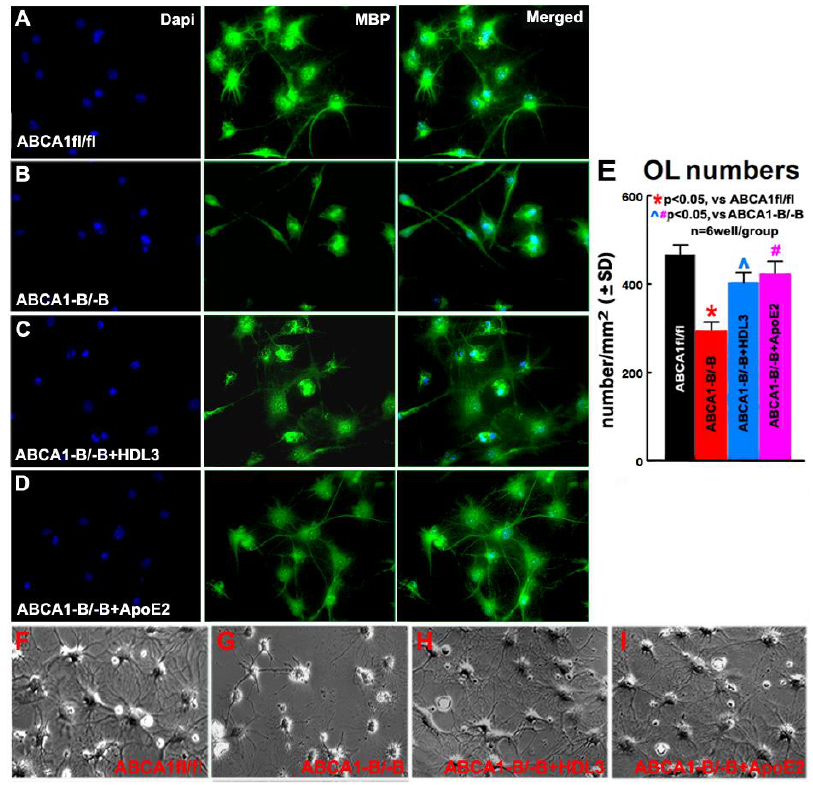
Figure 7. ABCA1-deficient decreases OL maturation, while treatment with ApoE2 or HDL3 significantly increases ABCA1 -B/-B -derived OL maturation. The images of MBP + -OLs derived from ABCA1 fl/fl ( A ), ABCA1 -B/-B ( B ), treated ABCA1 -B/-B -OPCs with HDL3 ( C ) or ApoE2 ( D ), and phase-contrast ( F – I ) obtained on DIV9, i.e., 6 days after initiation of treatment on DIV3. The quantities data of MBP + -OLs ( E ) were measured 6 days after treatment. * p < 0.05, vs. ABCA1 fl/fl -OLs; ^, # p < 0.05, vs. ABCA1 -B/-B -OLs; n = 6 wells/group.